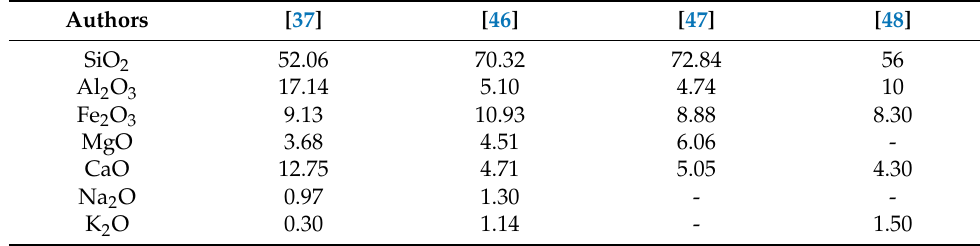
Table 1. Chemical composition of iron ore tailings (IOT).